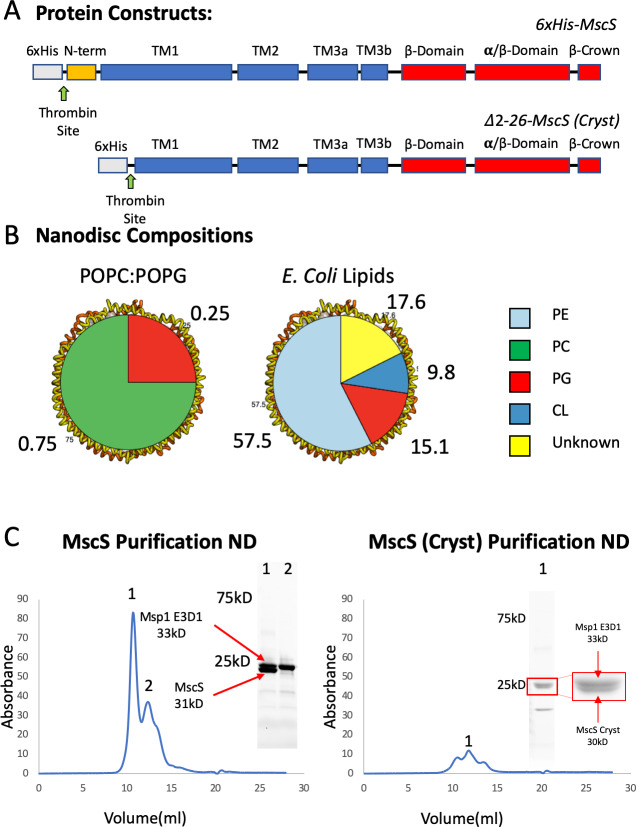
MscS Constructs, Nanodisc Composition, and Purification MscS Nanodiscs.(A) Overall construction design of wt MscS and MscS-Cryst (Δ2–26). (B) Nanodisc (ND) lipid compositions. (C) Left. A Superdex 200 size exclusion chromatography trace of wt MscS reconstituted in POPC:POPG ND. Inside the trace are the major peaks 1 and 2 ran on a stain free SDS PAGE. Peak one was used for Cryo-EM. Right. A Superdex 200 size exclusion chromatography trace of MscS-Cryst reconstituted in POPC:POPG ND. Inside the trace is the major peak one ran on a stain free SDS PAGE. Peak one was used for Cryo-EM.